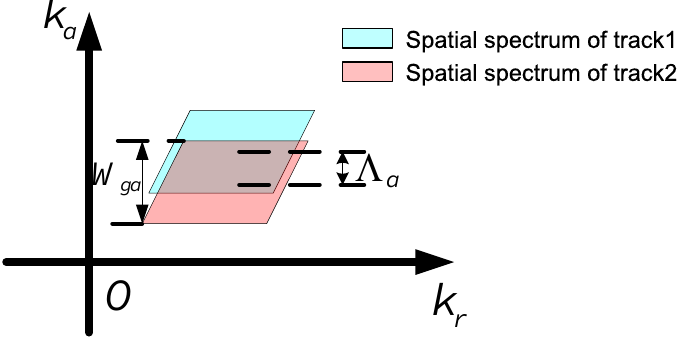
Figure 2. Two-dimensional (2D) spatial spectra of the GEO InSAR pair. frequency in the azimuth direction, and